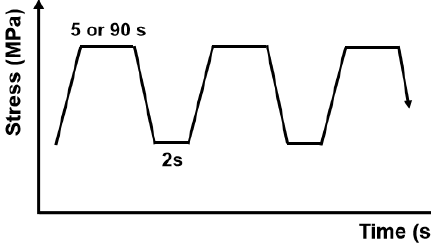
Figure 2. Trapezium waveform used in fatigue–creep–environment interaction-loading conditions: 15